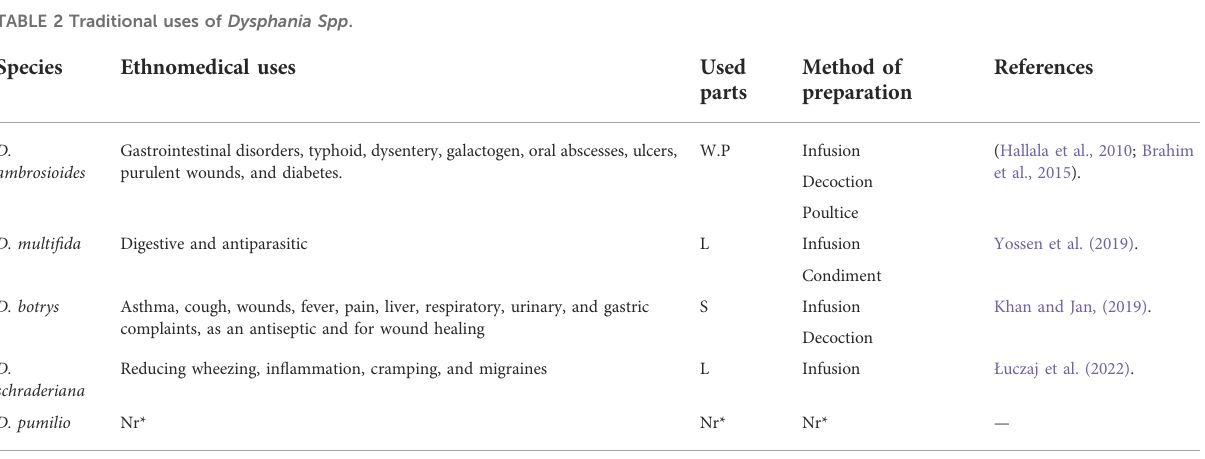
TABLE 2 Traditional uses of Dysphania Spp